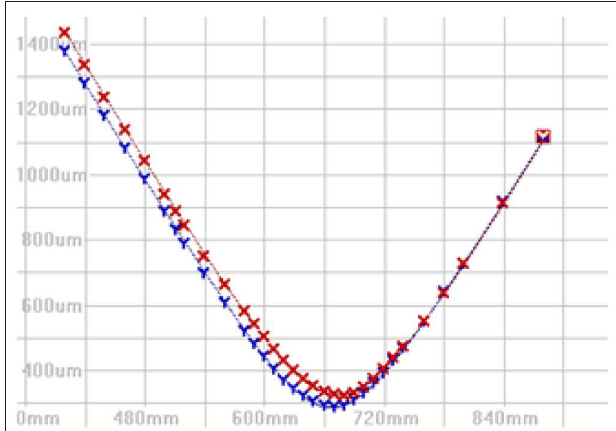
FIGURE 7 | M 2 measurement of the power-scaled dissipative soliton pulses at the main